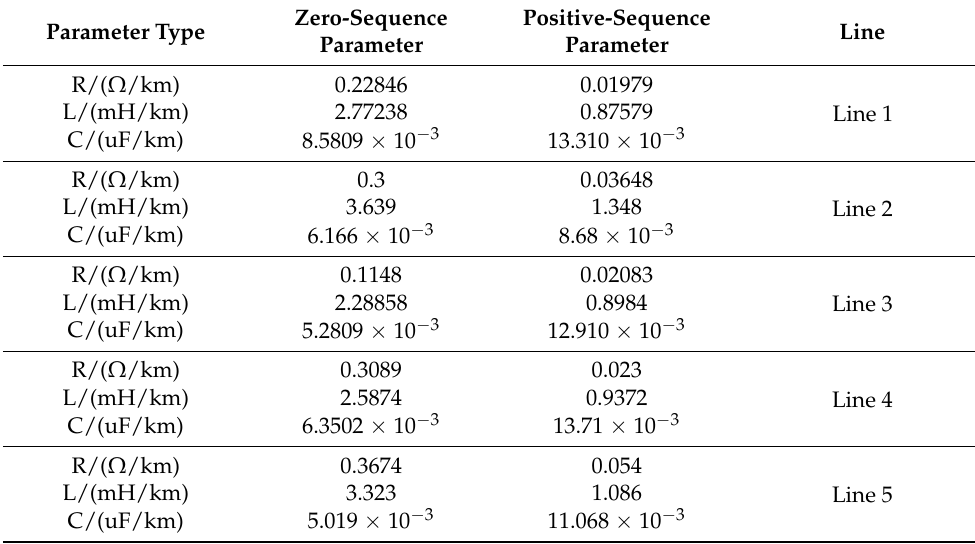
Table A2. Parameters of different